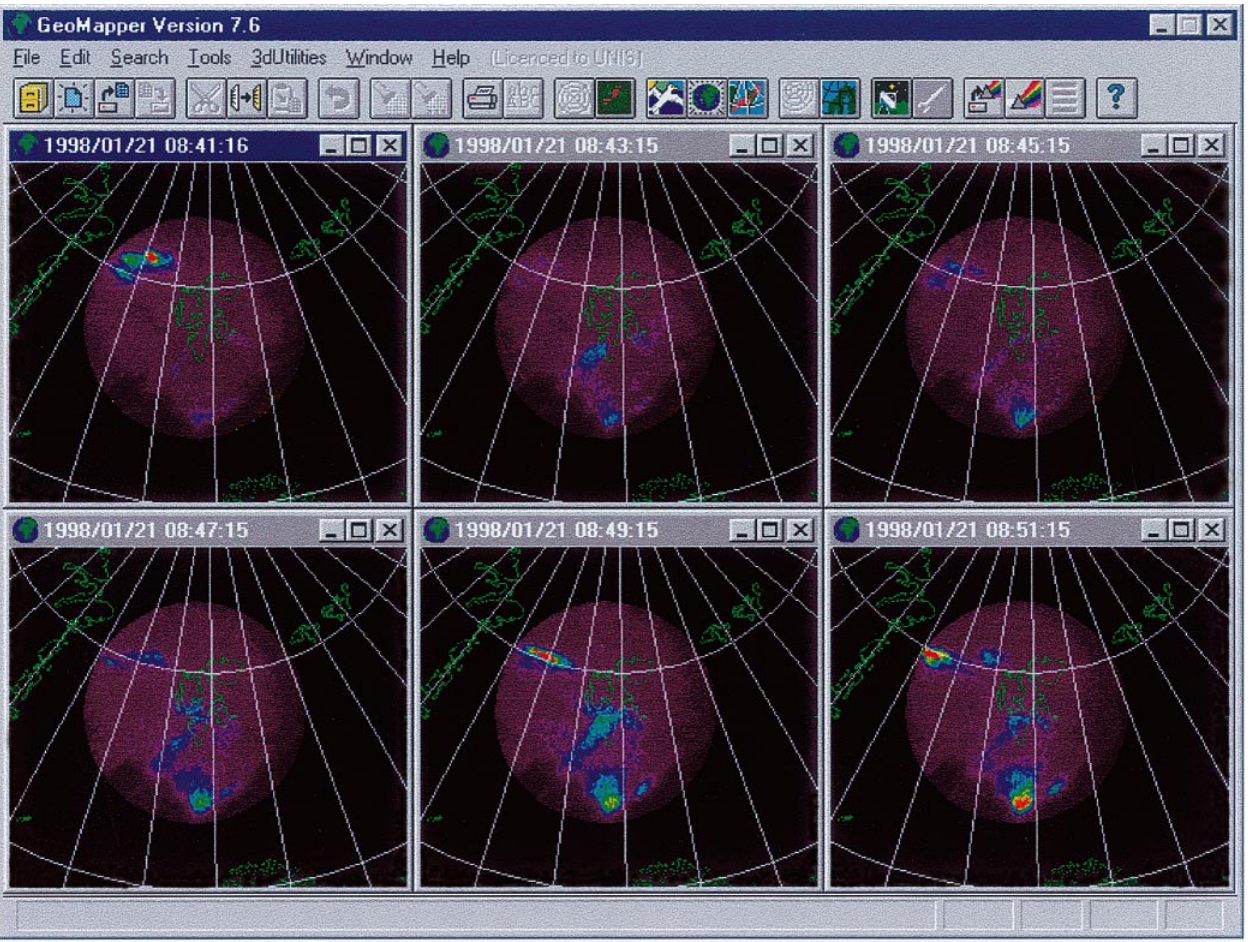
Fig. 3. Images from the all-sky camera located at Longyearbyen at 2 min intervals between 0841 and 0851 UT. The latitudinal scale shows 70 (cid:176) N and 80 (cid:176) N, while the longitudinal scale is at intervals of 10 (cid:176)